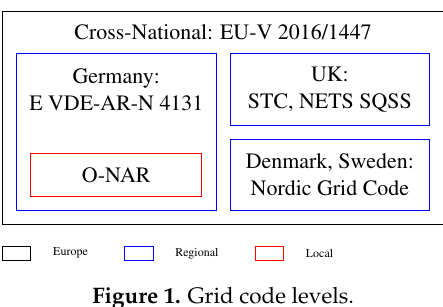
Figure 1. Grid code